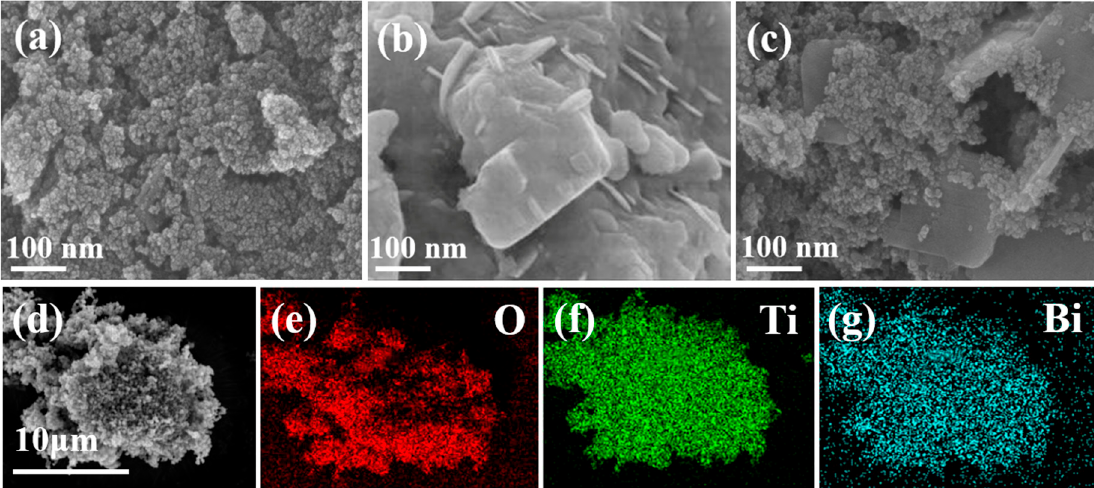
Figure 3. SEM images of ( a ) TiO 2 NPs, ( b ) Bi 2 O 3 , and ( c ) TB-3; ( d – g ) EDS elemental mapping images of